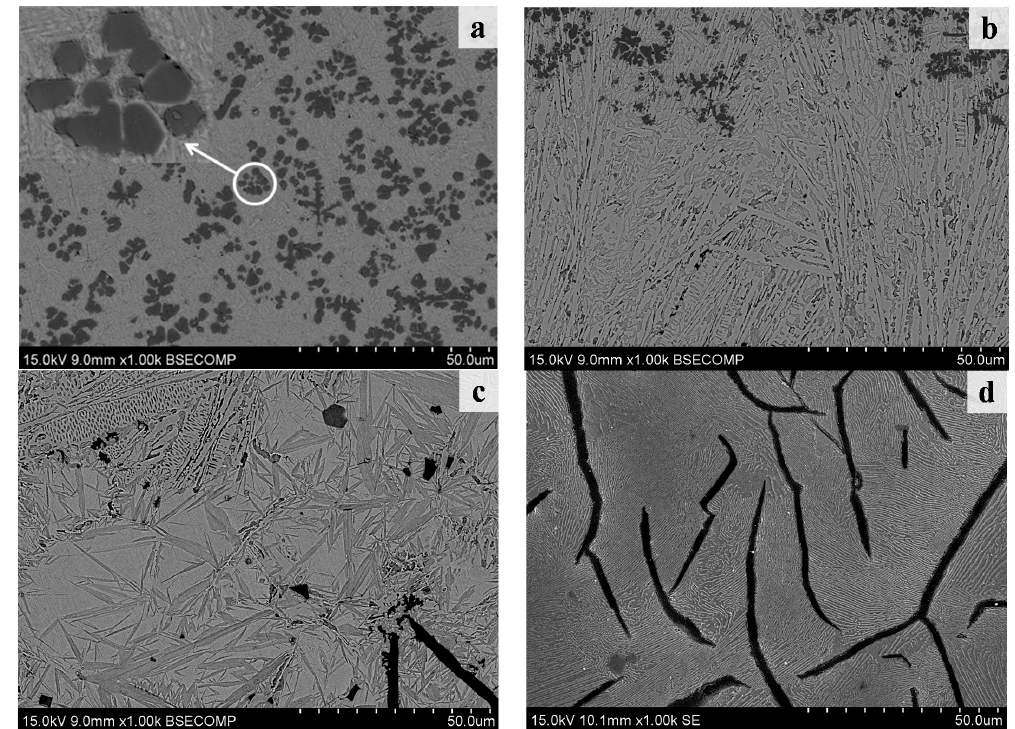
Figure 3. The magnifying BSE images of different zone of the laser cladding coating. ( a ) Laser cladding zone; ( b ) transition zone; ( c ) heat-affected zone; and ( d ) substrate zone.